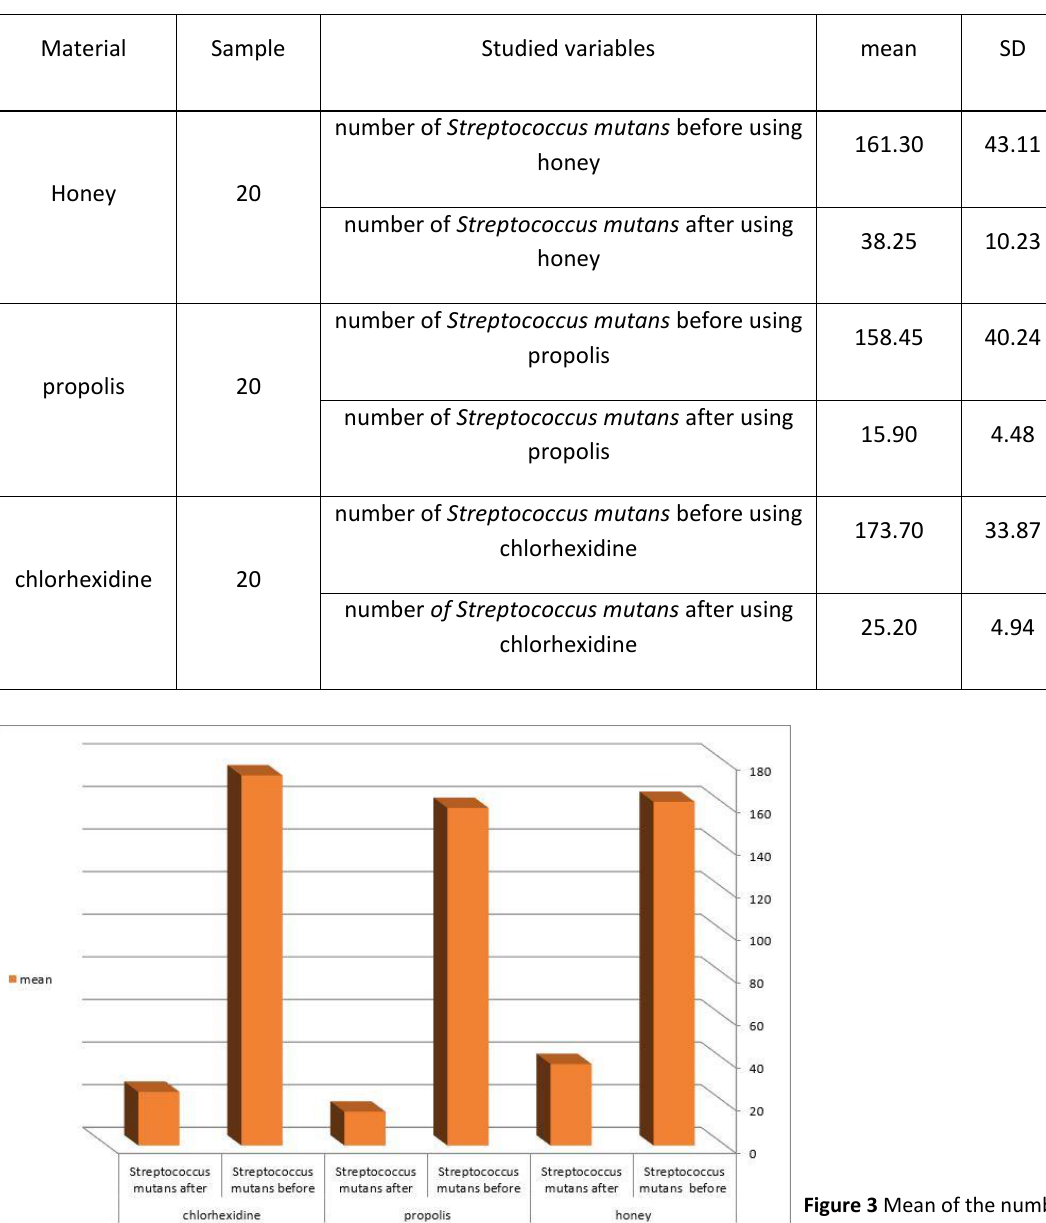
Figure 3 Mean of the number of Streptococcus mutans in the research